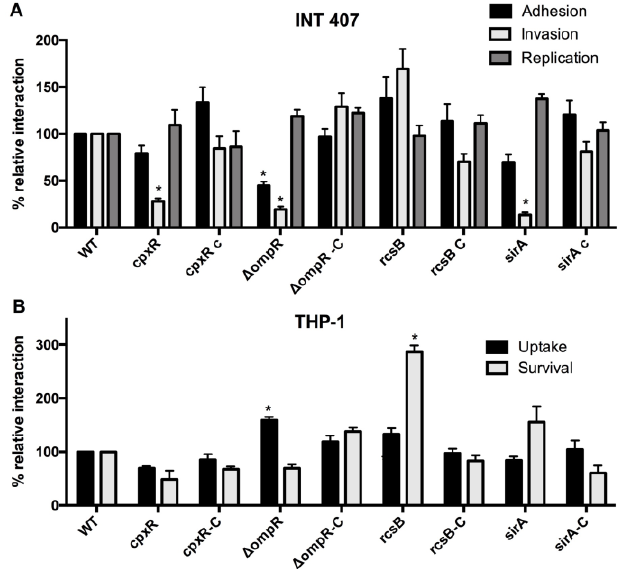
Figure 3. Complementation. Epithelial INT-407 cells ( A ) and THP-1 macrophages ( B ) were infected with S . Typhi wild-type strain, the cpxR, ompR, rcsB , and sirA mutants and complemented mutants with a wild-type copy on a low-copy vector. All assays were conducted in triplicate and repeated independently at least three times. The results are expressed as the mean ± SEM of the replicate experiments. Significant di ff erences (* p < 0.0001) in the level between the wild-type and the mutant were determined by the Student’s unpaired t -test. The dashed line corresponds to the wild-type level.